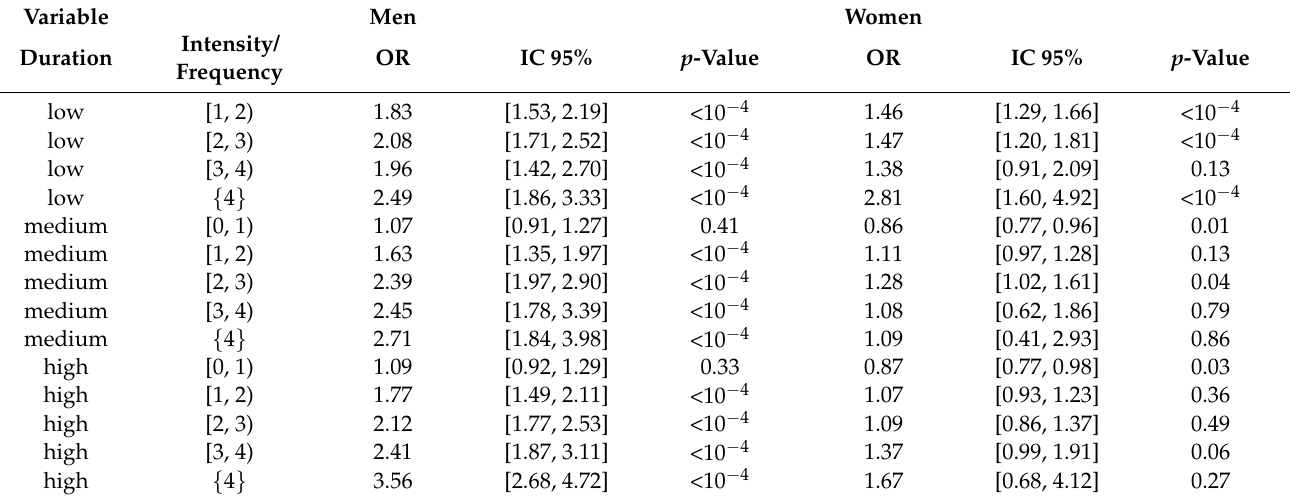
Table 4. Results of adjusted logistic regression of severe knee pain with lifting, for men and women separately.